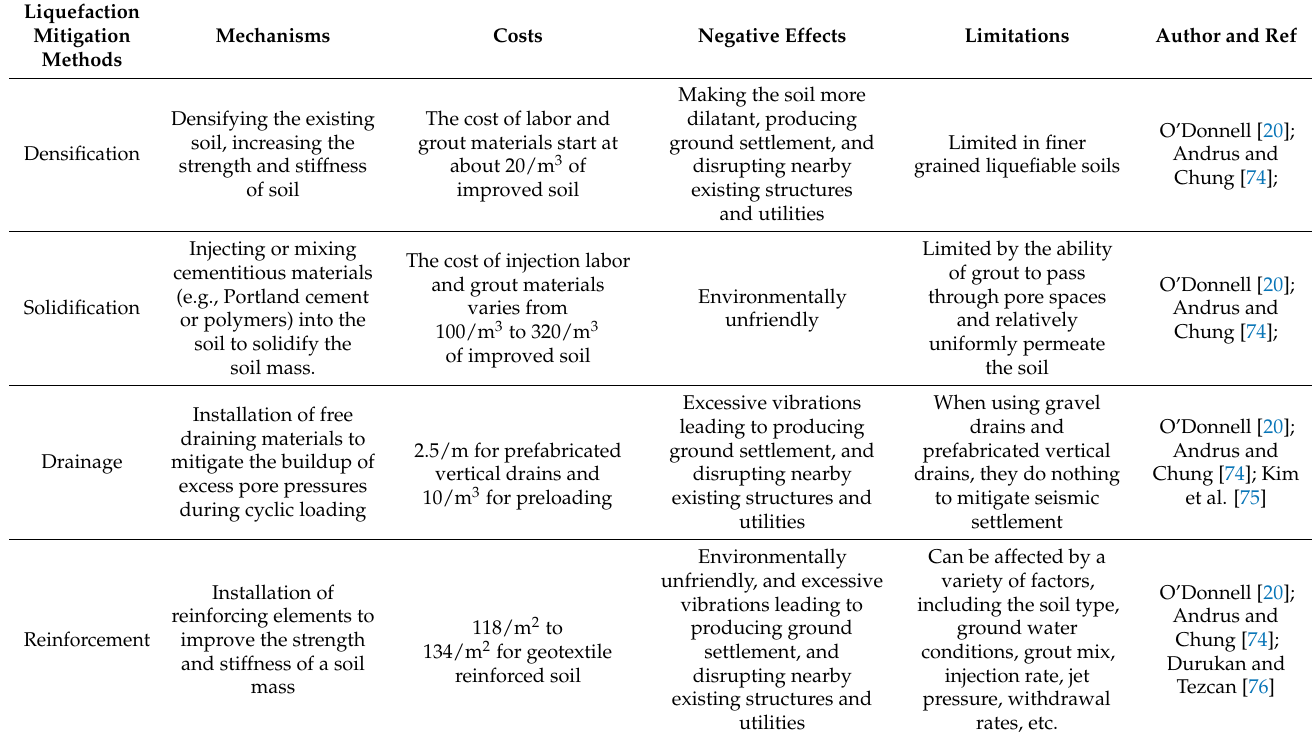
Table 4. Comparisons of the existing liquefaction mitigation